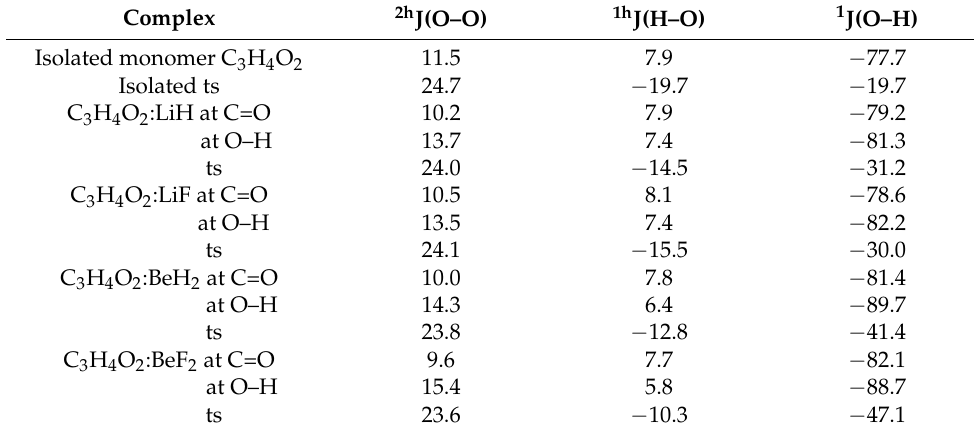
Table 3. Spin–spin coupling constants 2h J(O–O), 1h J(H–O), and 1 J(O–H) (Hz) for the O–H ... O hydrogen bond in complexes C 3 H 4 O 2 :Acid.